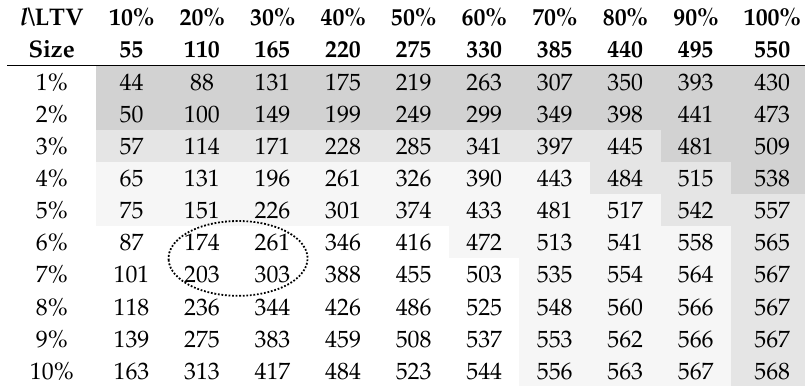
Table 2. Expected present values of the reverse mortgage under different loan interest rates and LTV ratios for a homeowner aged 75.